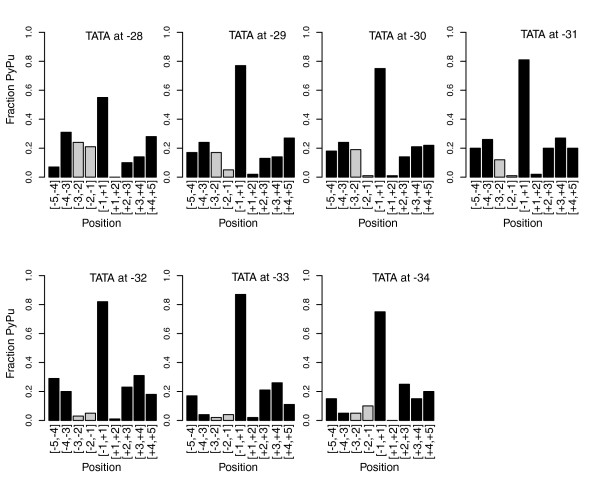
Extended TATA-TSS distances require unambiguous PyPu initiation sites. The fraction of PyPu dinucleotides in a sliding 2 bp wide window was calculated for each TATA spacing class in the [-5, +5] promoter region. Promoters with extended TATA-TSS distances (32-34 bp) are depleted of PyPu dinucleotides immediately upstream of the dominant TSS [-1,+1] (namely, [-2,-1] and [-3,-2]; fraction of PyPu dinucleotides shown as grey bars) and have a PyPu consensus at this site. Introduction of PyPu dinucleotides in this region would probably create new TSSs with a more favored distance to the TATA box. The PyPu distribution is largely symmetrical in promoters where the TATA box is located at position -31 to -29, indicating a possible intrinsic stretching mechanism within the PIC for selecting strong initiation sites located further away than the most favored distance (30 or 31 bp). bp, base pairs; PIC, pre-initiation complex; Pu, purine; Py, pyrimidine; TSS, transcription start site.